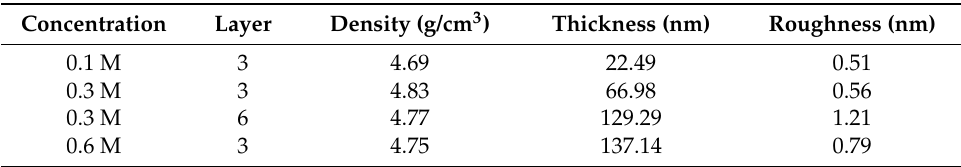
Table 1. The summary of density, thickness, and roughness of 0.1 M, 0.3 M, and 0.6 M precursor-based ZrO 2 film of different coating